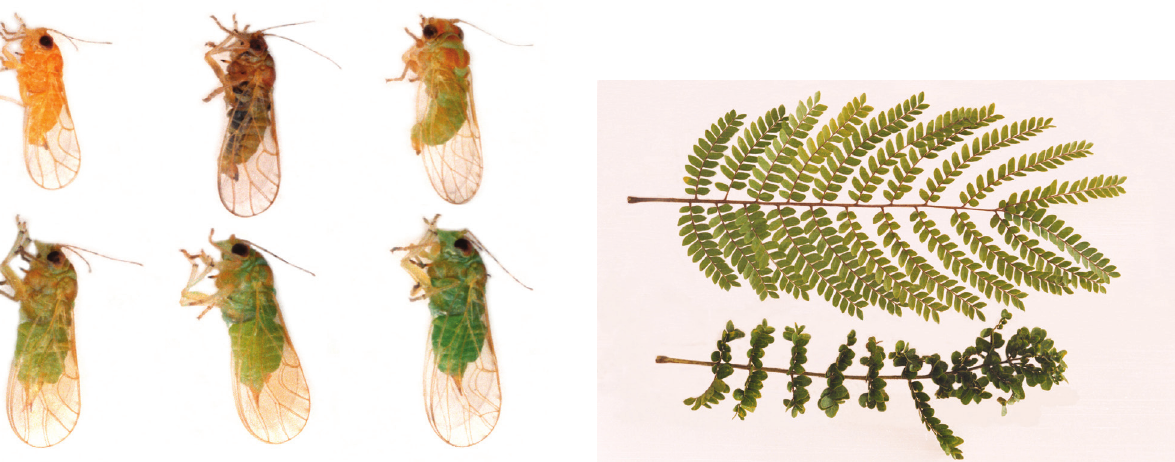
Figura 2 . Poincianella pluviosa (Fabaceae). Planta hospedeira de Isogonoceraia divergipennis.